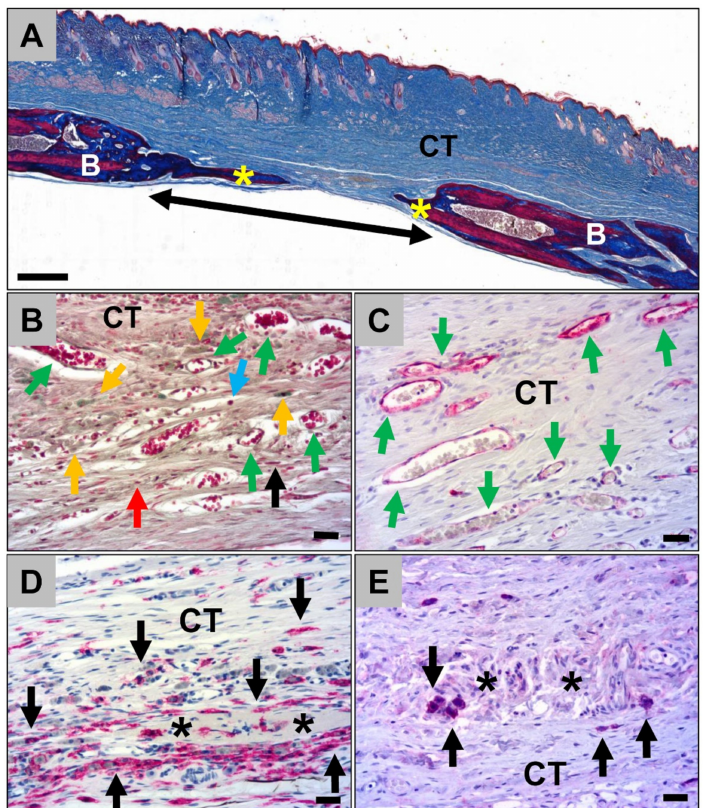
Figure 8. Representative histological images of the bony implantation beds of the jellyfish collagen sca ff olds at day 60 post implantationem . ( A ) Overview of a bony implantation site (double arrow). Yellowasterisks = newlyformedbone, B = localbone, CT = connectivetissue(“totalscan”, Azan-staining, 10 × magnification, scale bar = 1 mm). ( B ) Cell- and vessel-rich connective tissue (CT) within the calvarial defects. Orangearrows = macrophageswithanincreasedcytosolicvolume, blackarrows = macrophages, red arrows = fibroblasts, blue arrows = lymphocytes, green arrows = blood vessels (Movat’s Pentachome-staining, 20 × magnification, scale bar = 20 µ m). ( C ) Vascularization pattern (green arrows = blood vessels) of the connective tissue within the calvarial defects (CD31-immunostaining, 20 × magnification, scalebar = 20 µ m). ( D ) Immunohistochemical detection of anti-inflammatory macrophages (black arrows). Asterisks = remnants of the jellyfish collagen sca ff olds, CT = connective tissue (CD163-immunostainings, 20 × magnifications, scalebars = 20 µ m). ( E ) Immunohistochemical detectionofpro-inflammatorymacrophages(blackarrows). Asterisks = remnantsofthejellyfishcollagen sca ff olds, CT = connective tissue (CD11c-immunostainings, 20 × magnifications, scalebars = 20 µ